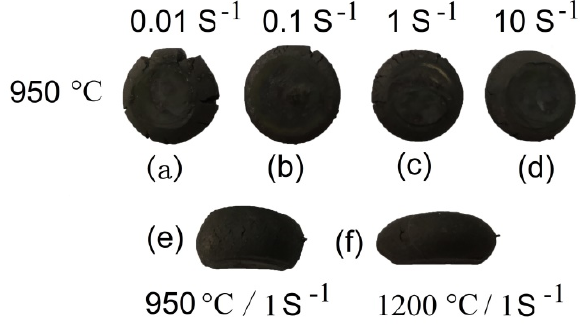
Figure 14. The cracks on the surface of samples of 2W.